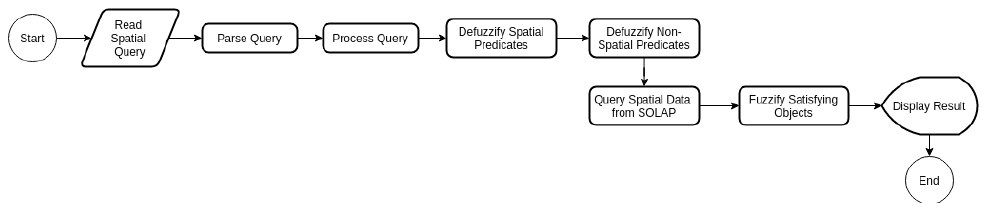
Figure 12. Fuzzy spatial query flow. Query 2: Retrieve the appropriate cities for the installation of a solar power